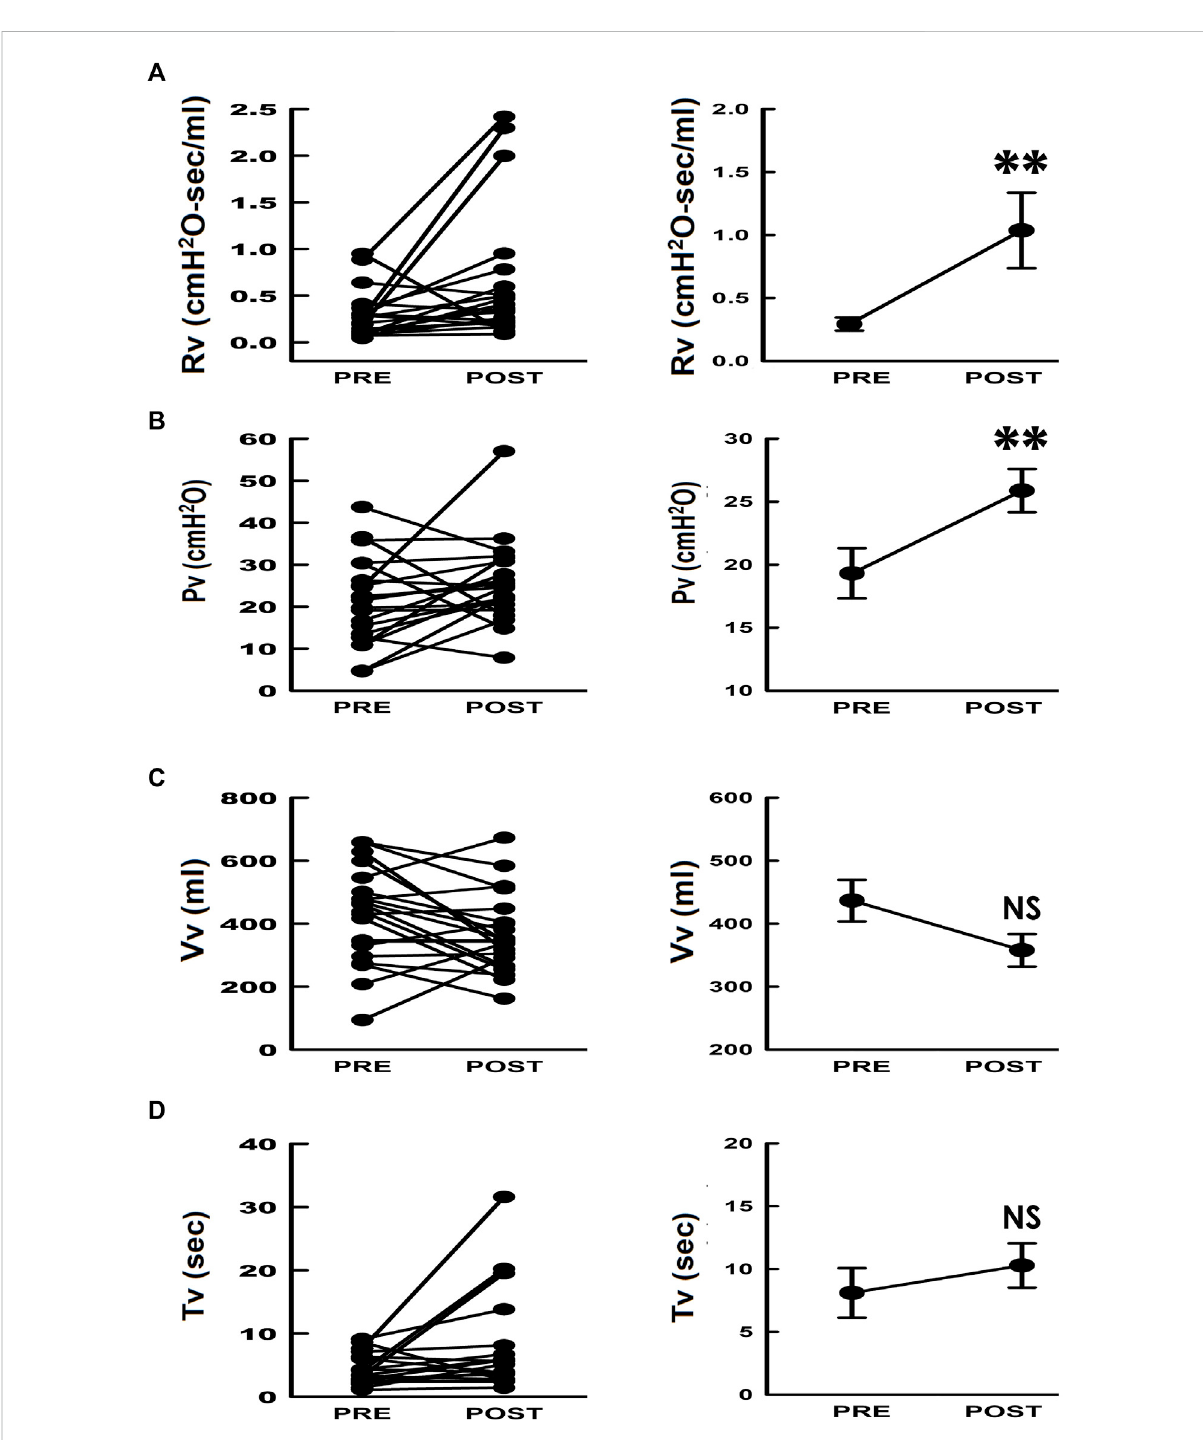
FIGURE 4 Individual and summarized data of voiding parameters in response to TOT surgery. (A – D) individual (left) and summarized (right) data of the mean voiding resistance (Rv), mean voiding pressure (Pv), voided volume (Vv), and voiding time (Tv), respectively. (** p < 0.01, NS p > 0.05 vs. PRE; N =